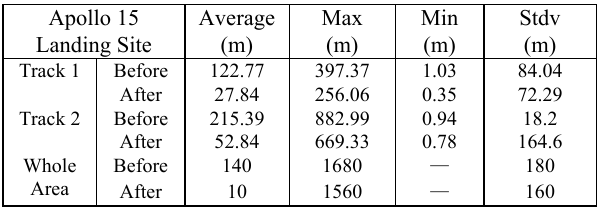
Table 4. Statistical data for each track and the whole area of 2D grey-scale images at Apollo 15 Landing Site area before and after Least Squares